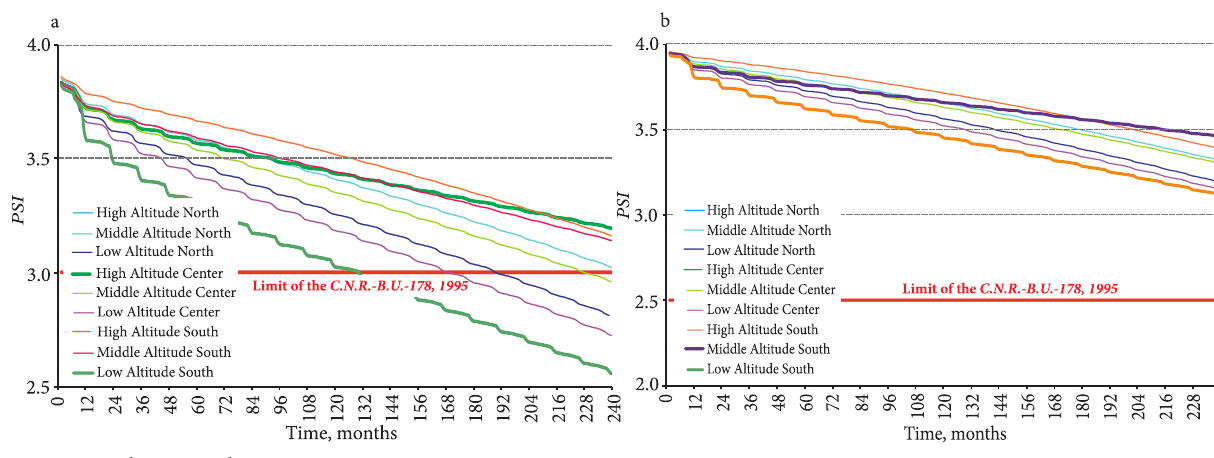
fig. 6. Simulation PSI decay: